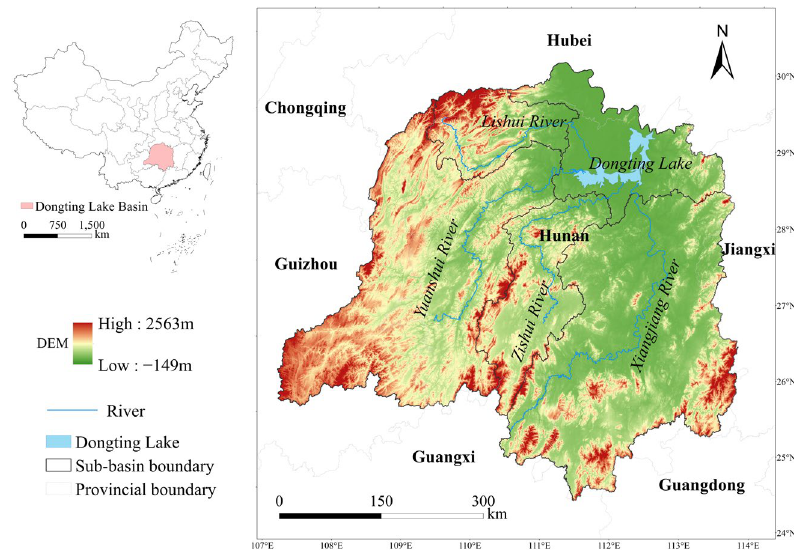
Figure 1. Study area.